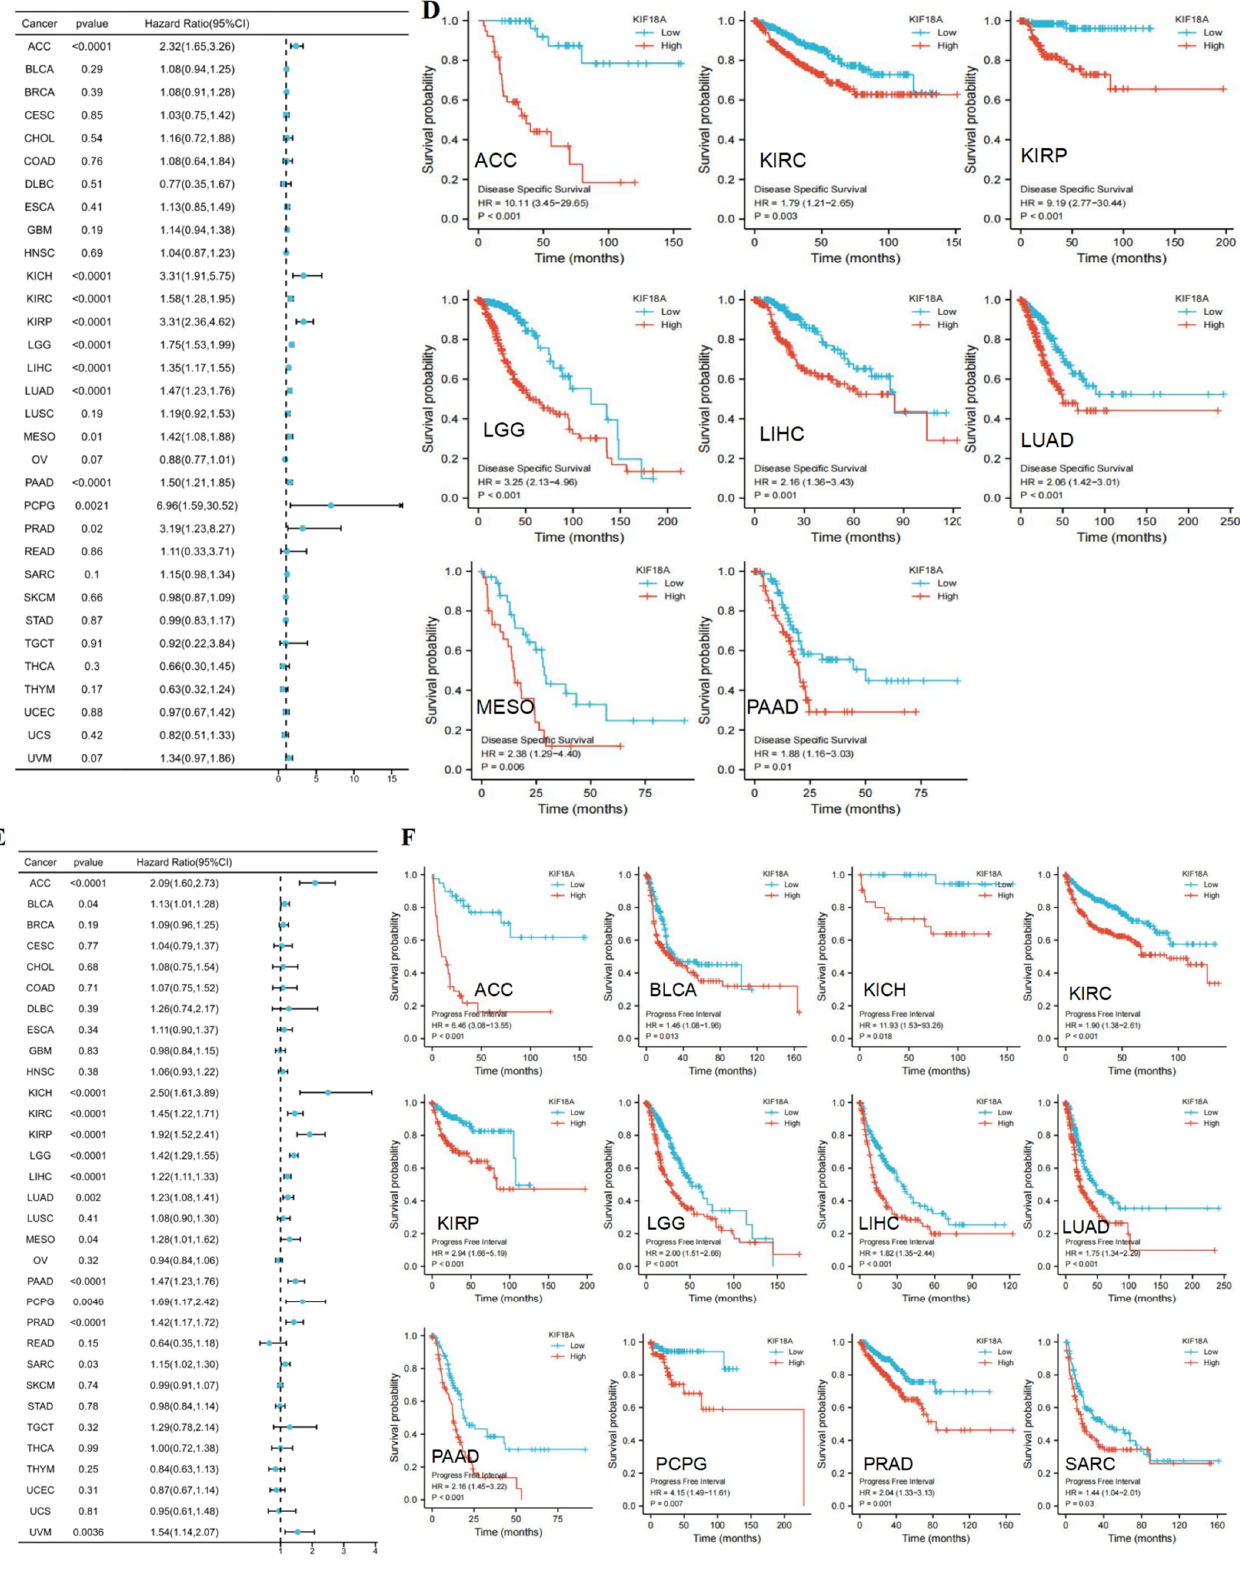
Figure 3. The univariate regression and Kaplan − Meier curves for OS ( A , B ), DSS ( C , D ), and PFI ( E , F ) in pan − cancer.